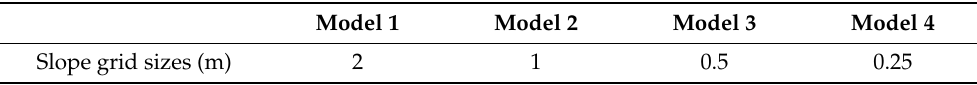
Table 3. Models with different slope grid sizes.